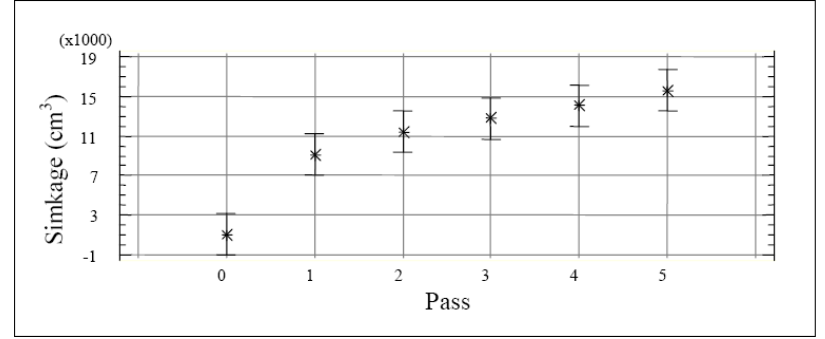
Figure 6. Means and 95% LSD Intervals, sinkage vs. pass